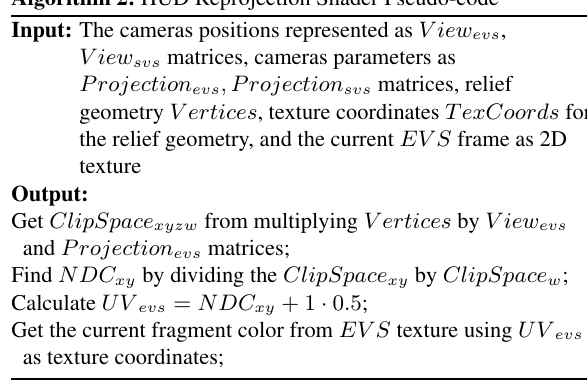
Algorithm 2: HUD Reprojection Shader